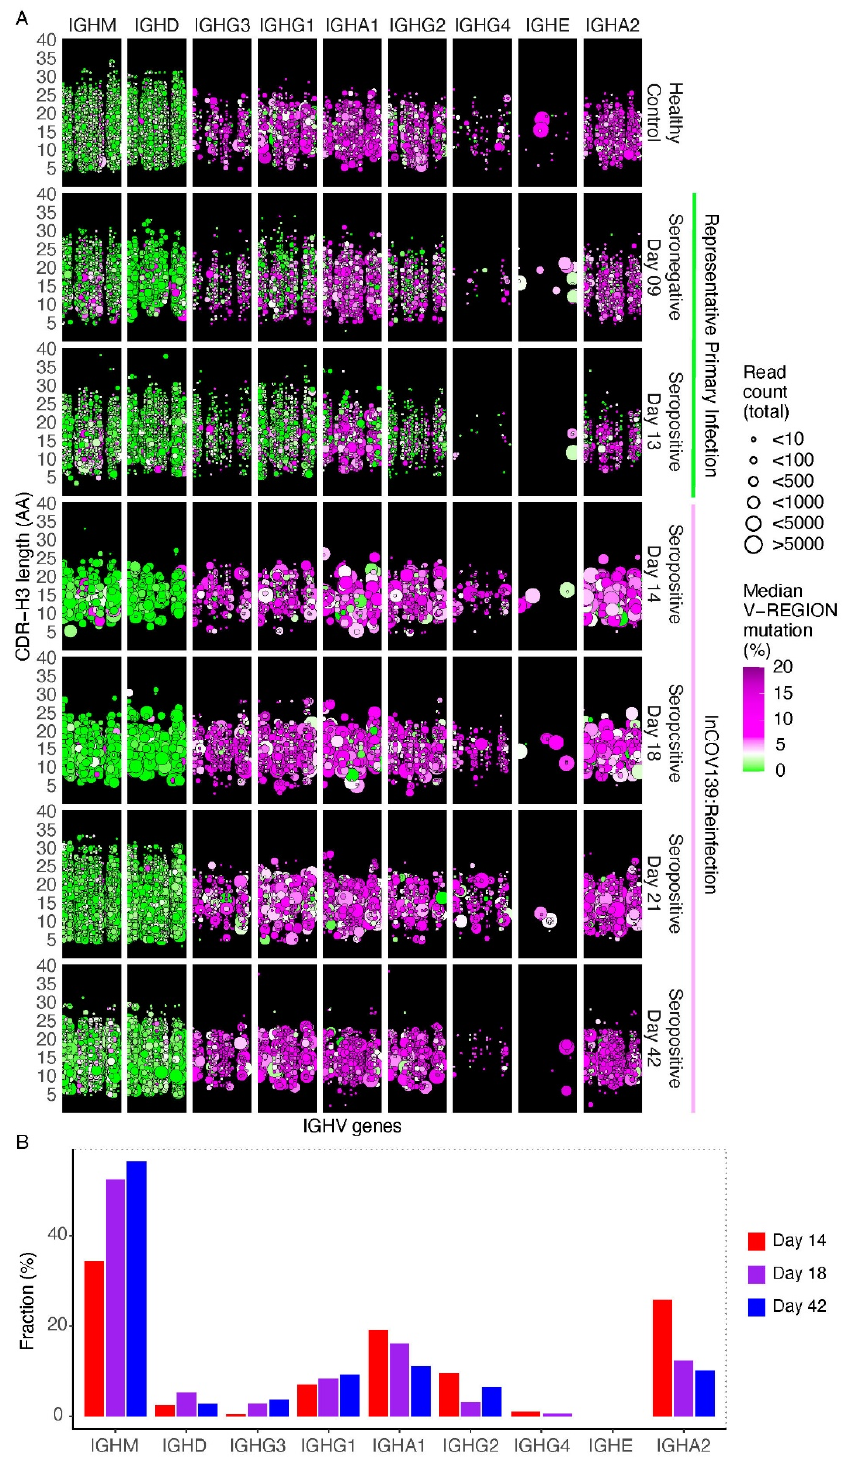
Figure 4. B cell repertoire responses. Panel ( A ): Peripheral blood B cell IGH gene repertoires from pe ‐ ripheral blood mononuclear cell RNA. Three individuals were sampled: a representative healthy con ‐ trol (top row); a patient with representative primary SARS ‐ CoV ‐ 2 infection at day 9 and 13 post ‐ onset of symptoms (highlighted by green bar); and reinfected patient at day 14, 18 and 42 (pending) post ‐ onset of symptoms (highlighted by pink bar). Serostatus and days post symptoms onset are given on the right y ‐ axis. Columns indicate the class of each IGH sequence with the IGHV gene indicated on the x ‐ axis. The left y ‐ axis indicates CDR ‐ H3 length in amino acids (AA). Dots indicate B cell clonal lineages. Point color indicates median IGHV somatic hypermutation frequency for each clone, and